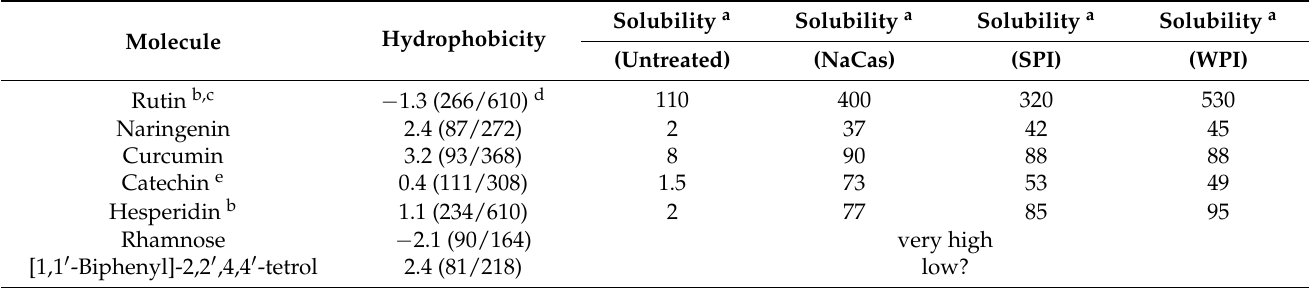
Table 1. Properties of polyphenols and their